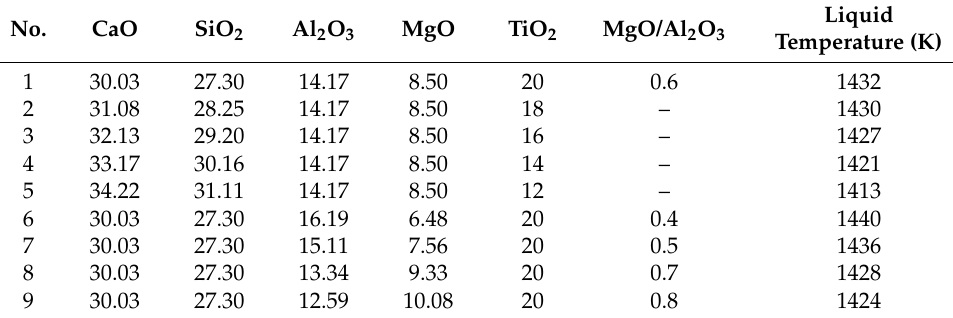
Table 1. Experimental compositions of slags